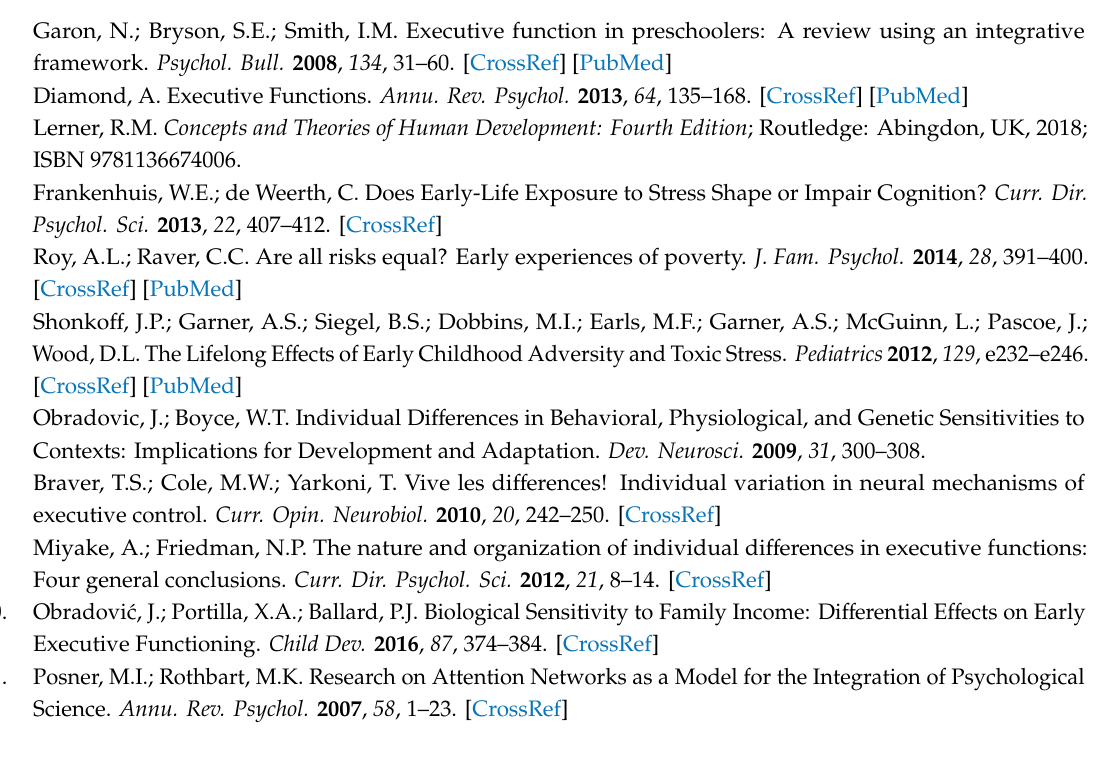
Table S16: Child ANT performance summary data for experimental groups in assessment phases (general variables); Table S17: Child ANT performance summary data for experimental groups in assessment phases (congruent and incongruent trials); Table S18: Correlation between variables for Child ANT in general variables; Table S19: Correlation between variables for Child ANT in congruent and incongruent trials; Table S20: Child ANT task nonparametric statistical comparison between and within experimental groups; Table S21: Child ANT task performance summary data for low-performance experimental groups in assessment phases; Table S22: Child ANT task performance summary data for low-performance experimental groups in assessment phases; Table S23: Child ANT task performance summary data for high-performance experimental groups in assessment phases; Table S24: Child ANT task performance summary data for high-performance experimental groups in assessment phases; Table S25: Child ANT task Kruskal–Wallis nonparametric statistical comparison between performance and experimental groups for pre- and post-training phases; Table S26: ANT task nonparametric planned comparisons in pre- and post- training assessments; Table S27: Child ANT task nonparametric statistical comparison within experimental groups for high- and low-performance